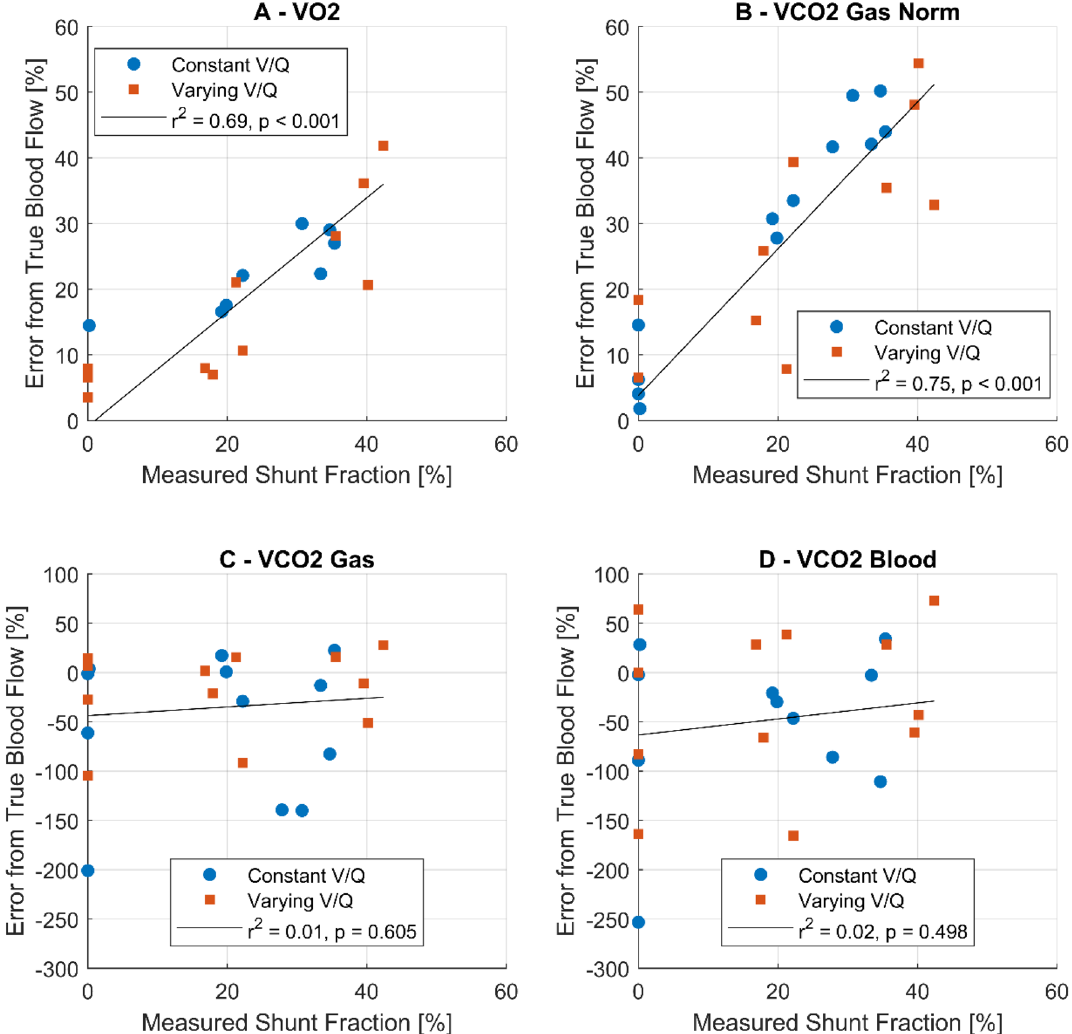
. . V O V CO . 2 ( A ), 2GasNorm normalized for ECMO V CO 2Blood ( D ). Maneuvers simulating